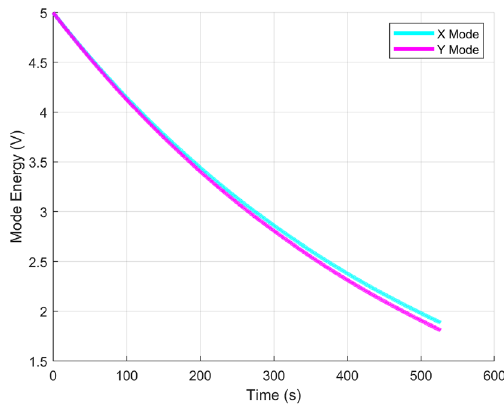
Figure 10. Ring down measurement of the two degenerated modes of the